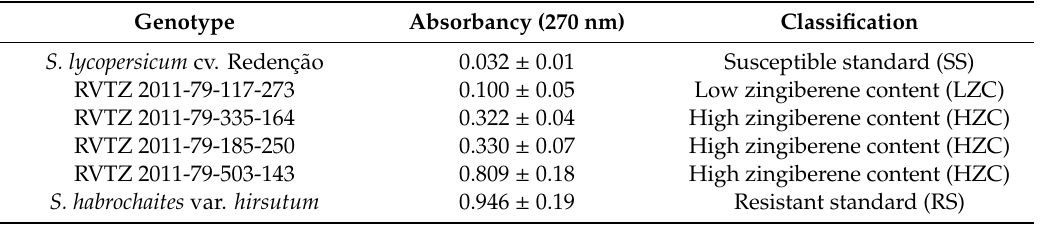
Table 1. Absorbancy at 270 nm (means ± SD) indicating the zingiberene content of tomato